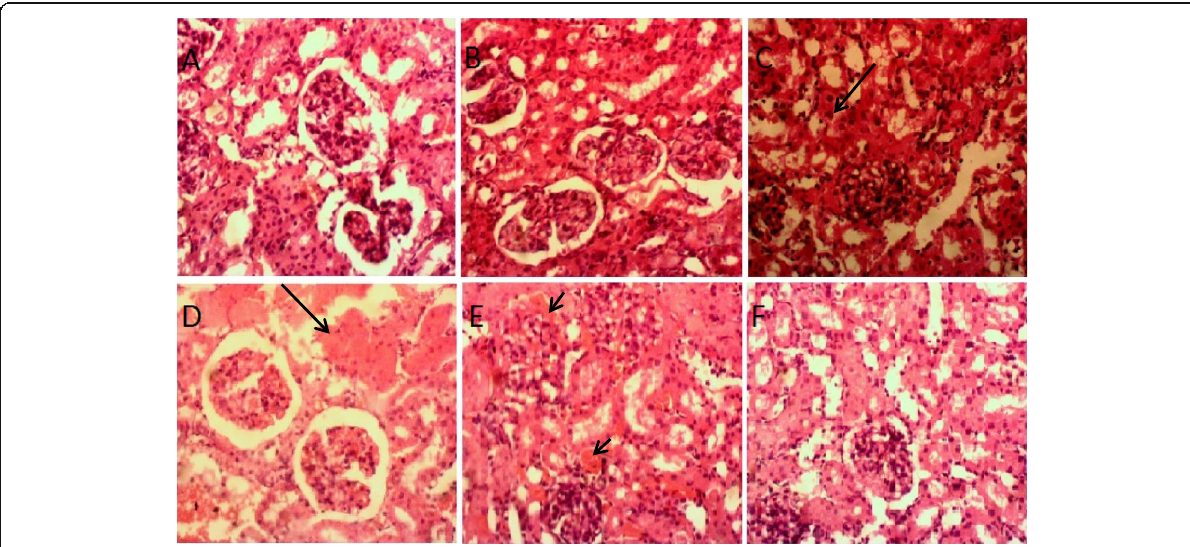
Fig. 2 Protective effect of ENS on NiCl 2 -induced alteration of renal histo-architecture in rats. Normal renal histology in the group treated with water a and 50 mg/kg ENS alone b . Tubular epithelial degeneration and necrosis c , Nephrosis with casts d and congestion of glomerular capillaries e observed in the group injected (i.p.) with NiCl 2 . Normal renal histology in the observed group that received a combination of ENS and NiCl 2. f